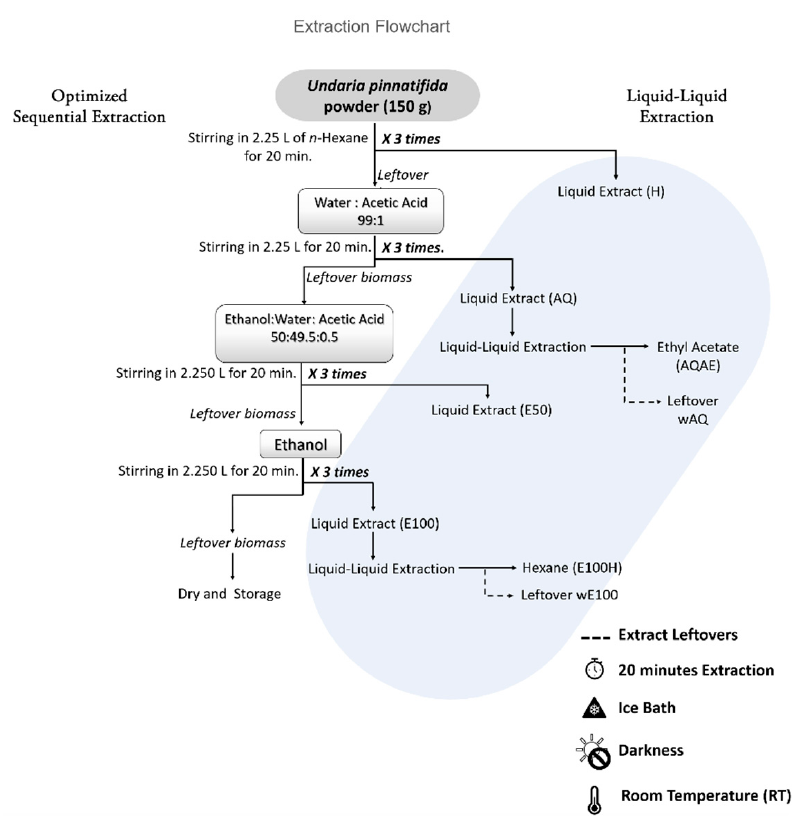
Figure 1. Scheme of the optimized sequential extraction of Undaria pinnatifida and the liquid–liquid extraction with the respective outputs (final six extracts on shadowed region).